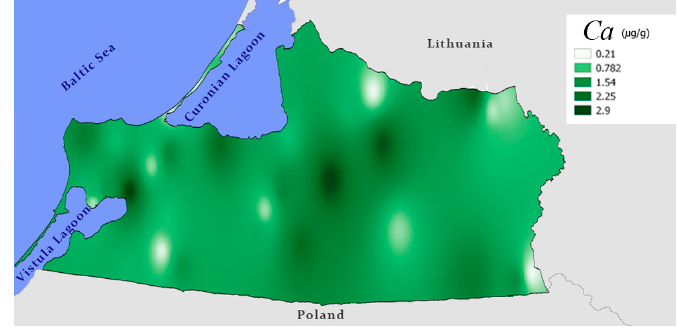
Figure 6. Distribution of calcium in the thalli of H. physodes in the Kaliningrad region, 2010.